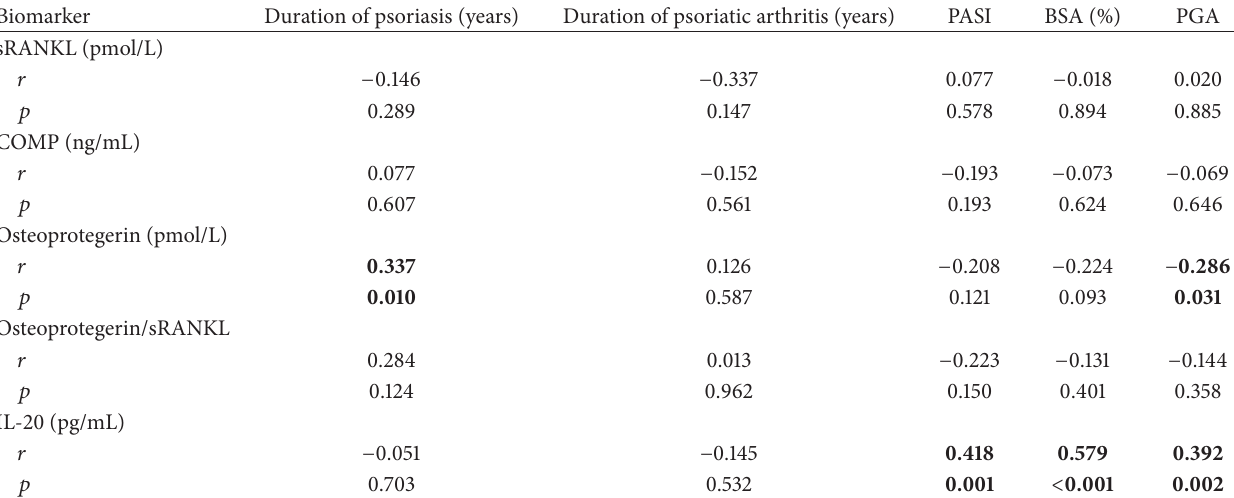
Table 5: Correlation coefficients between the biomarkers serum concentrations and clinical data in the psoriatic patients. Biomarker